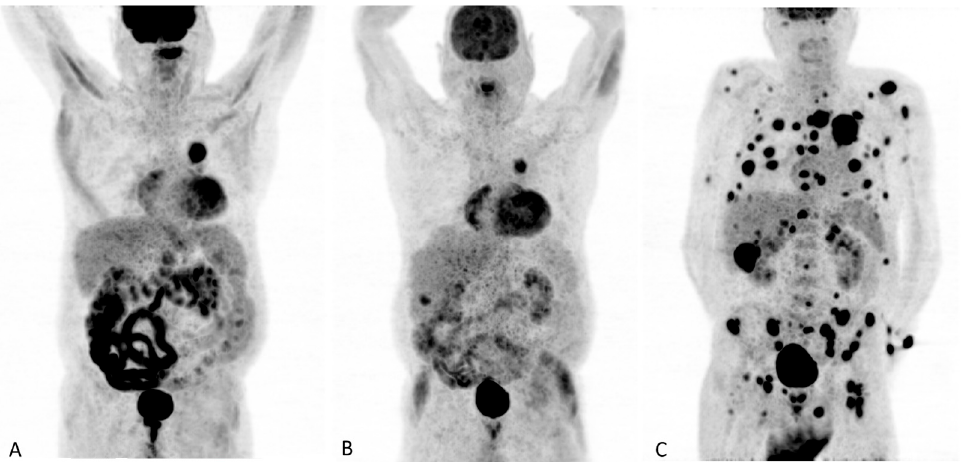
Figure 2. 77-year-old man being followed because of an adenocarcinoma in a sigma polyp. He presented an incidental finding of a lung mass located in the superior left lobe, later confirmed as a lung adenocarcinoma with evidence of loco-regional lymphadenopathic infiltration. ( A ) Third [ 18 F]FDG PET/CT showing radiological stability after chemotherapy. ( B ) Oligometastatic progression in liver parenchyma with solitary lesion after chemotherapy and radiotherapy. ( C ) After initiating immunotherapy (three cycles of Atezolimumab), [ 18 F]FDG PET/CT evidenced progression of the primary tumour and the liver lesion with countless liver, adrenal and bone lytic lesions as well as peritoneal implants, consistent with hyperprogression. The patient died one month later.